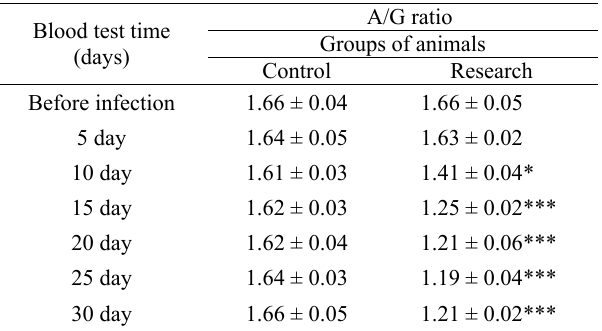
Coefficient of A/G in the blood of cows with experimental fasciolosis (M ± m, n =